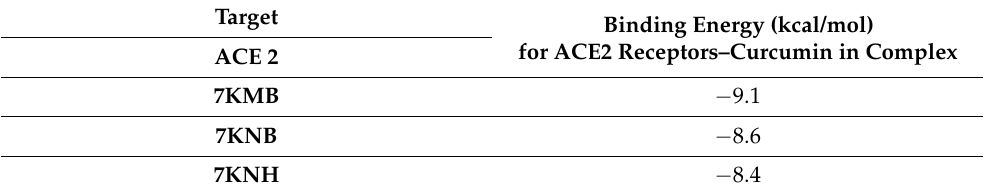
Table 4. The docking scores of curcumin with different targets (host cell receptors) in the curcumin– NLC complex. Target Binding Energy (kcal/mol) for ACE2 Receptors–Curcumin in ComplexACE 2